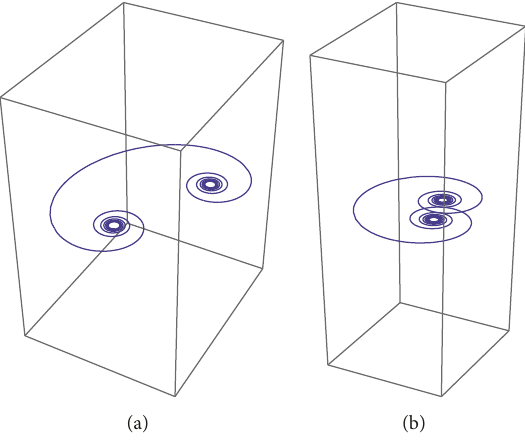
Figure 1: (a) 𝜅 1 (𝑠) = 5𝑠 2 + 3 , 𝜅 2 (𝑠) = 0 (b) 𝜅 1 (𝑠) = 𝑠 2 + 1 , 𝜅 2 (𝑠) = 0 .